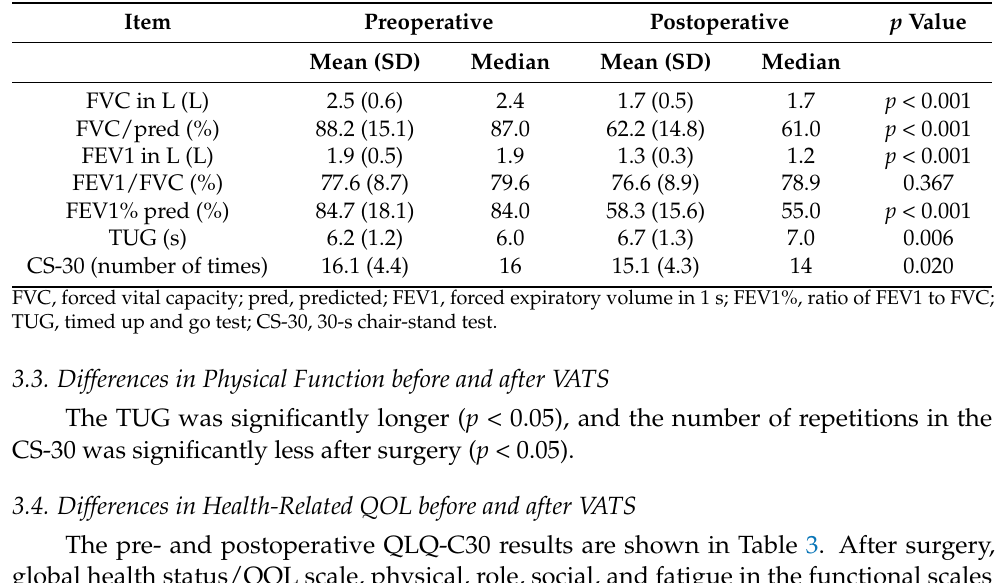
Table 2. Comparisons of lung function and physical function before and after surgery for lung cancer.